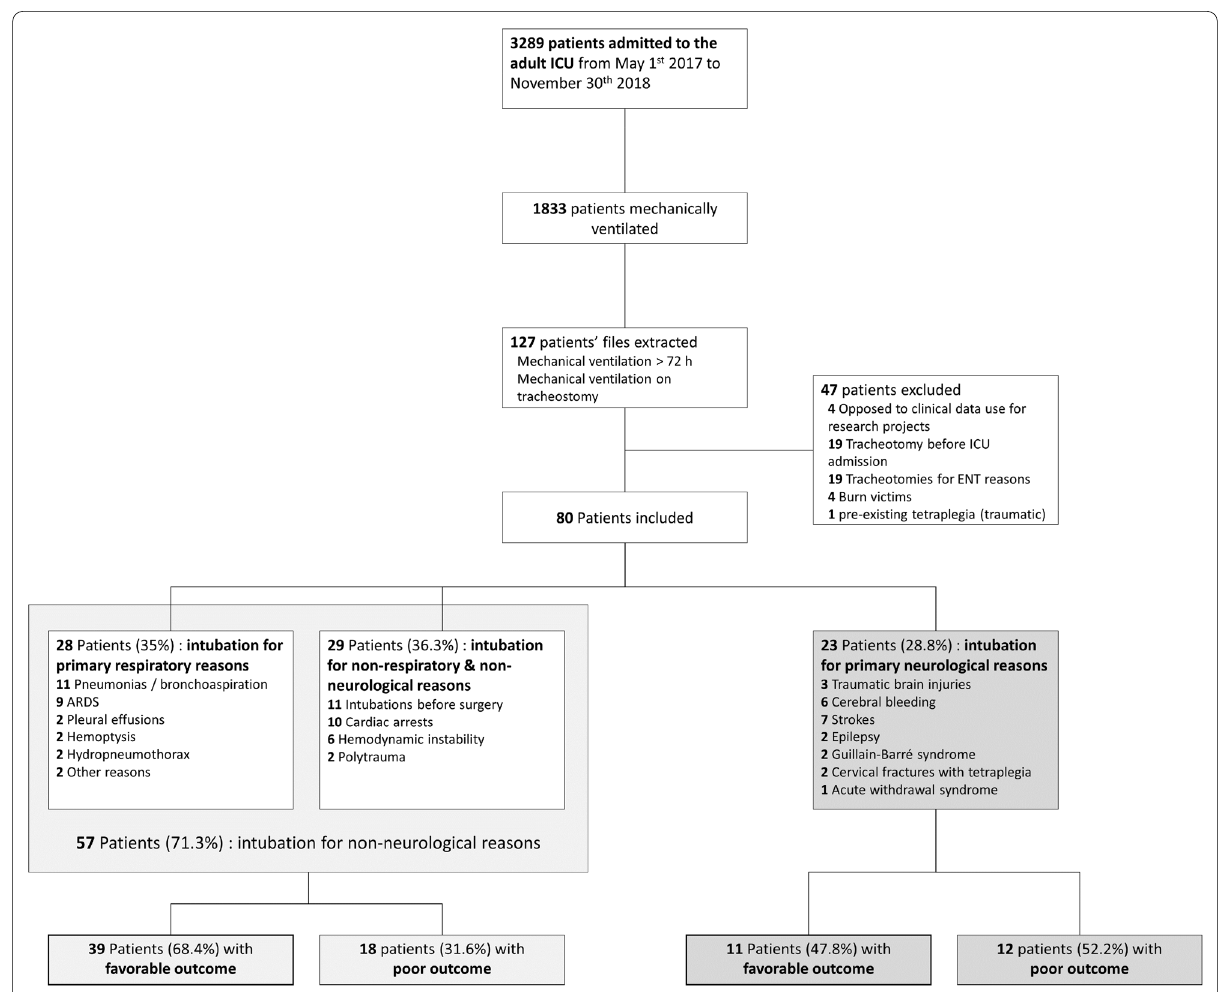
Fig. 1 Study flowchart. ICU intensive care unit, ENT ear–nose–throat, ARDS acute respiratory distress